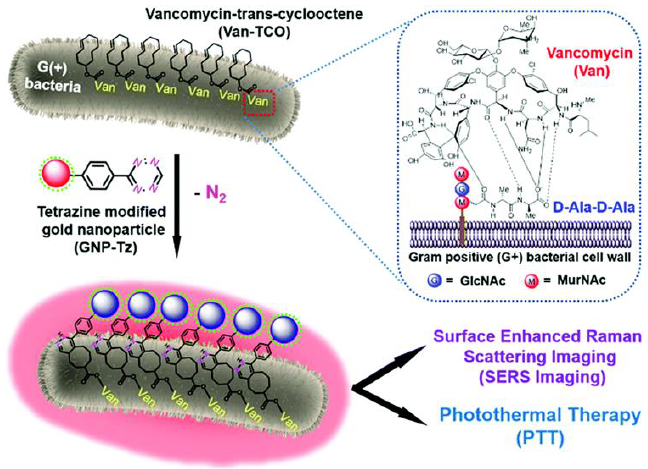
Figure 7. Scheme diagram of bacteria-induced gold nanoparticle aggregation for SERS imaging and enhanced photothermal ablation of Gram-positive bacteria. Firstly, vancomycin-trans-cyclooctene (Van-TCO) attached to the Gram-positive bacterial surface through five hydrogen bonds. Next, tetrazine-modified gold nanoparticle (GNP-Tz) conjugated with Van-TCO and in situ aggregated onto the bacterial cell wall via bioorthogonal cycloaddition, providing high efficiency for bacterial SERS imaging and photothermal antimicrobial therapy. Reproduced from [102], with permission from the Royal Society of Chemistry, 2019.